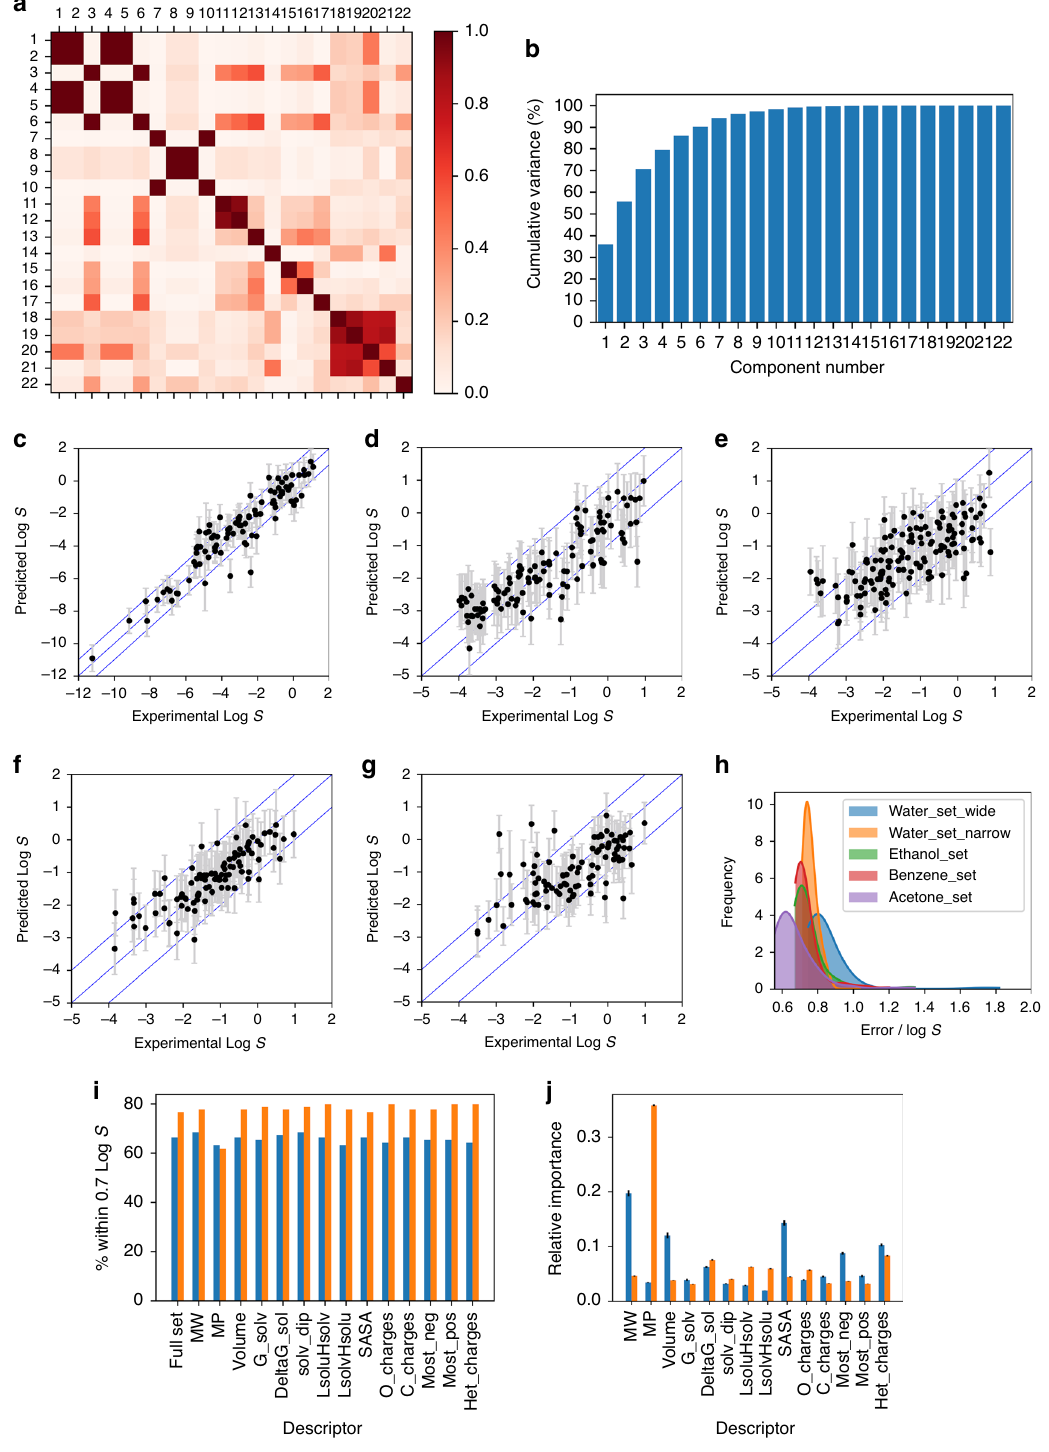
Fig. 2 Results of initial machine learning prediction models. a Descriptor correlation analysis, b principal component analysis of the descriptors with Water_set_wide; and plots of predicted vs experimental LogS, with predicted errors, using GP algorithm for c Water_wide_set, d Water_narrow_set, e Ethanol_set, f Benzene_set, g Acetone_set; and h distributions of predicted errors (1 standard deviation) for each dataset with GP; and i impact of the removal of a single descriptor on ET prediction models (blue: Water_set_wide, orange: Benzene_set), j feature importance plot for ET prediction models (blue: Water_set_wide, orange: